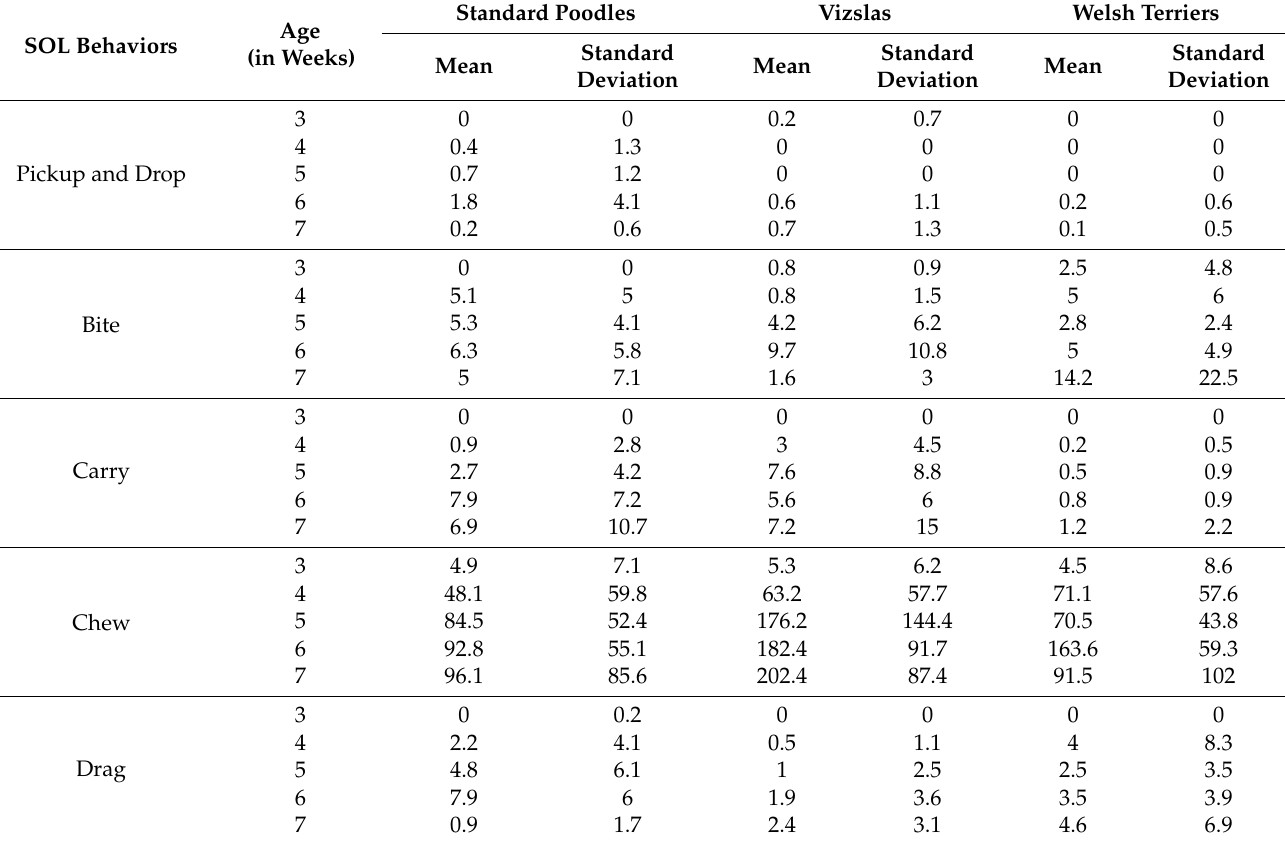
Table A2. Individual behaviors in the SOL play context for each breed. Mean and standard deviation of duration data for individual behaviors in the (solitary/SOL) play context for each breed at 3–7 weeks of